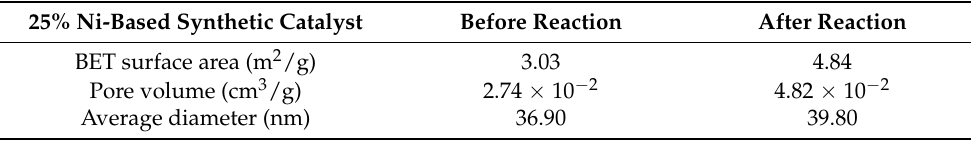
Figure 13. The nitrogen adsorption–desorption isotherms of the 25% Ni-based synthetic catalysts ( a ) before and ( b ) after catalytic reforming process. Table 2. BET characterization of synthetic catalysts before and after catalytic reforming